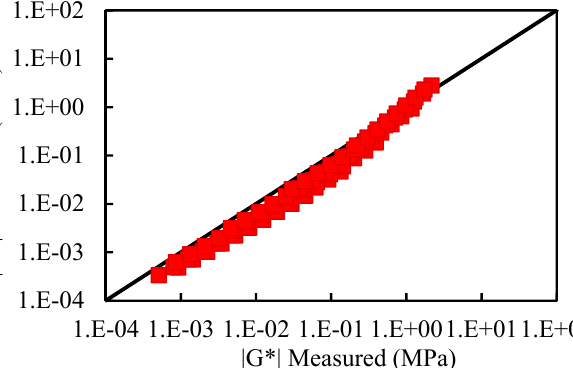
Figure 13. Comparison between the measured complex modulus of ZH70 (0.53A) with the